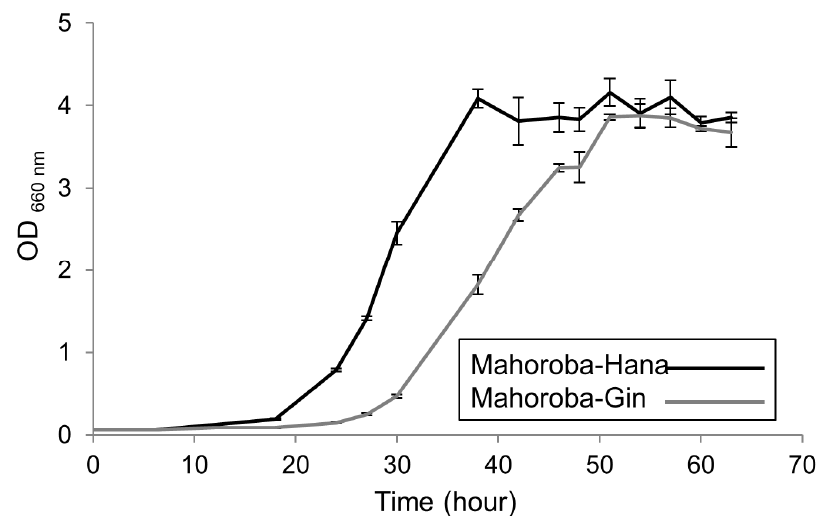
Figure 5. Growth curve of two yeast strains. Black shows Mohoroba-Hana strain and grey shows Mohoroba-Gin strain, each with OD = 660